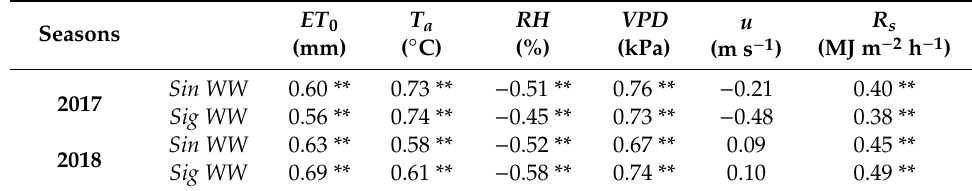
Table 5. Correlation coe ffi cient ( r ) between daily measured evapotranspiration rate ( ETR ) and weather variables including mean air temperature ( T a ), relative humidity ( RH ), wind speed ( u ), net radiation ( R s ), and vapor pressure deficit ( VPD ) for the two soybean varieties, Sinara ( Sin ) and Sigalia ( Sig ). Crops with unlimited watering ( WW ) were included in the study. ET 0 represents the Penman-Monteith reference